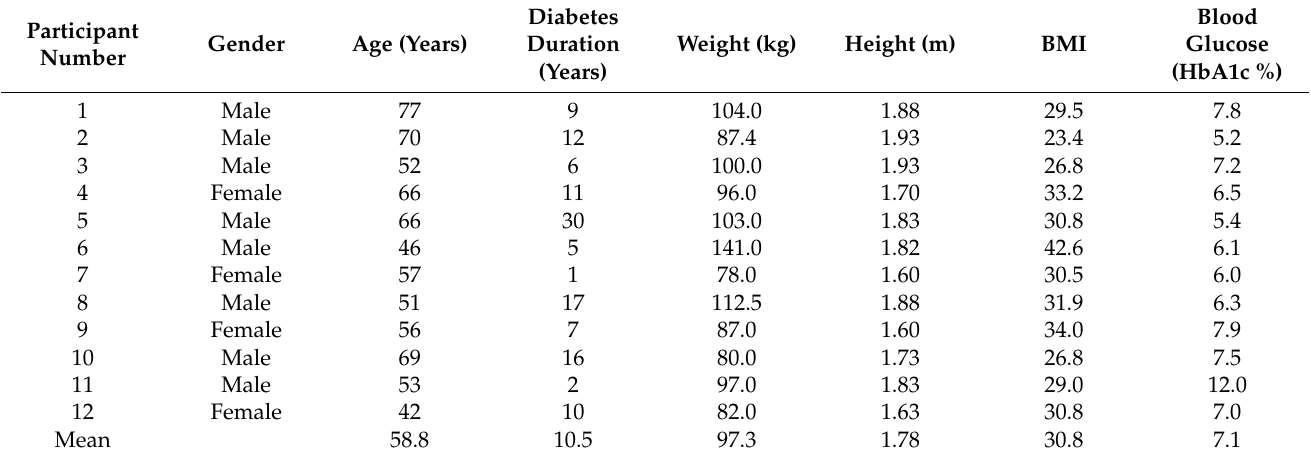
Table 1. Demographic and individual profiles of stage 1